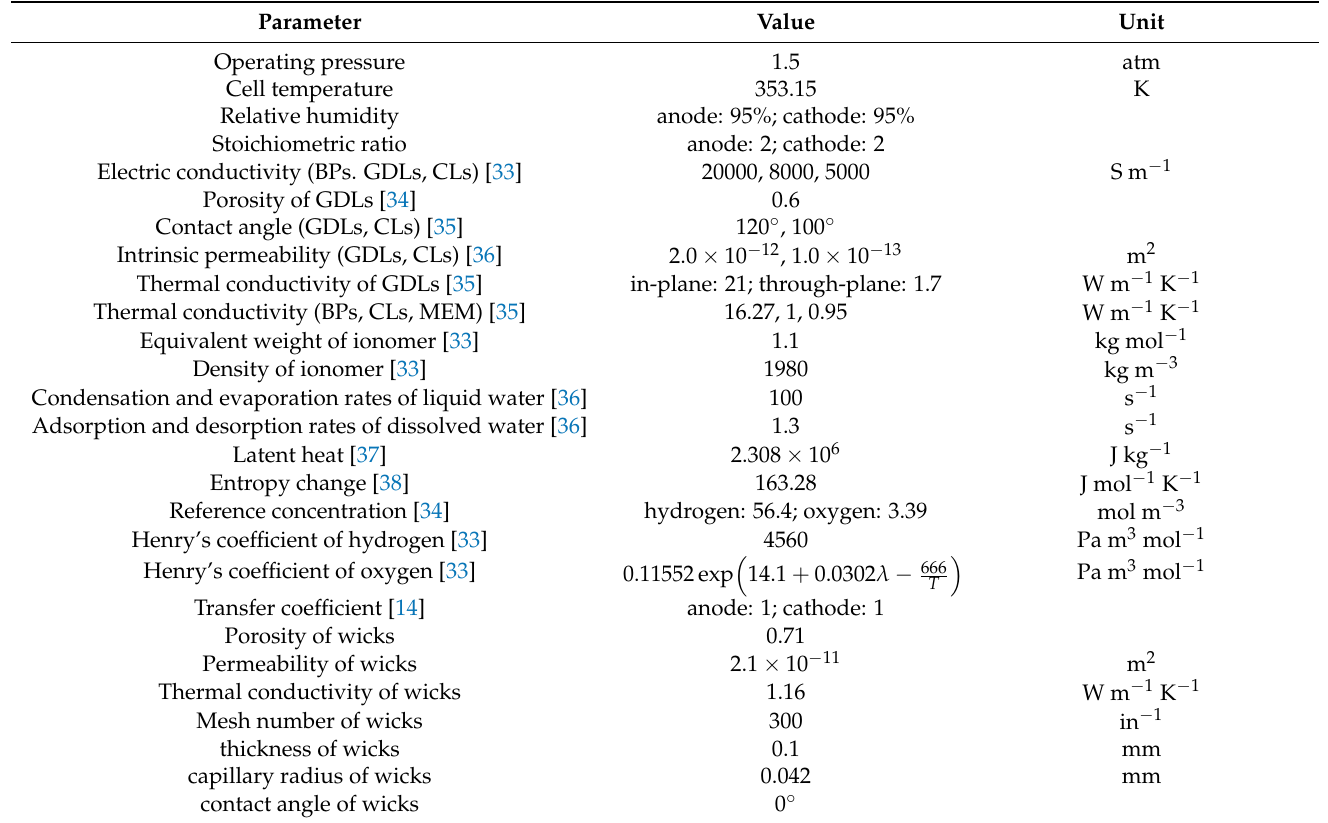
Table 1. Model parameters and operation